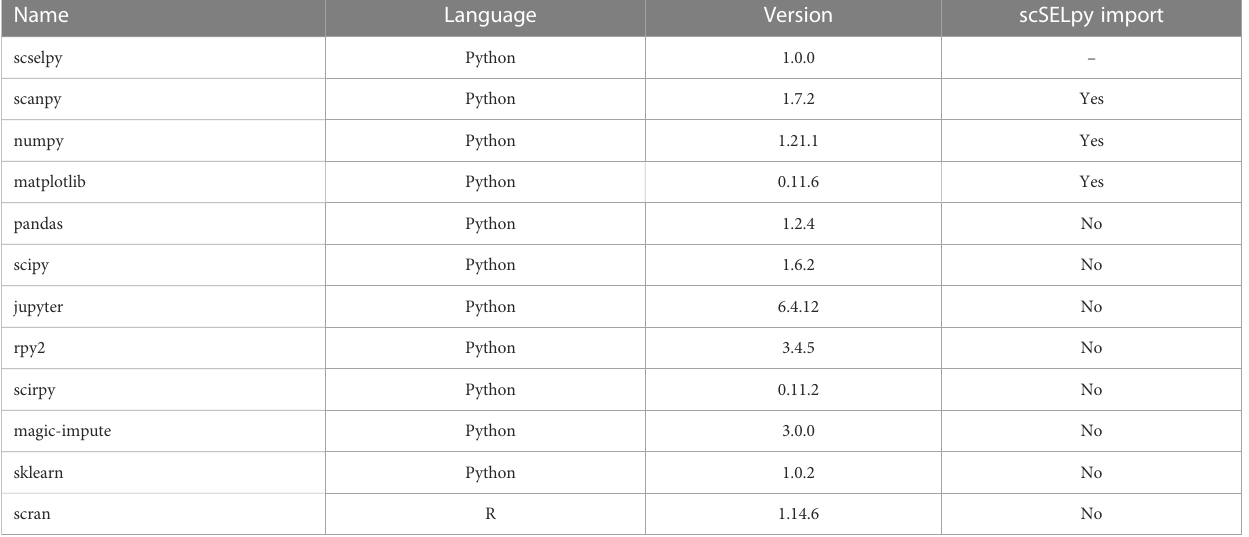
TABLE 1 Version